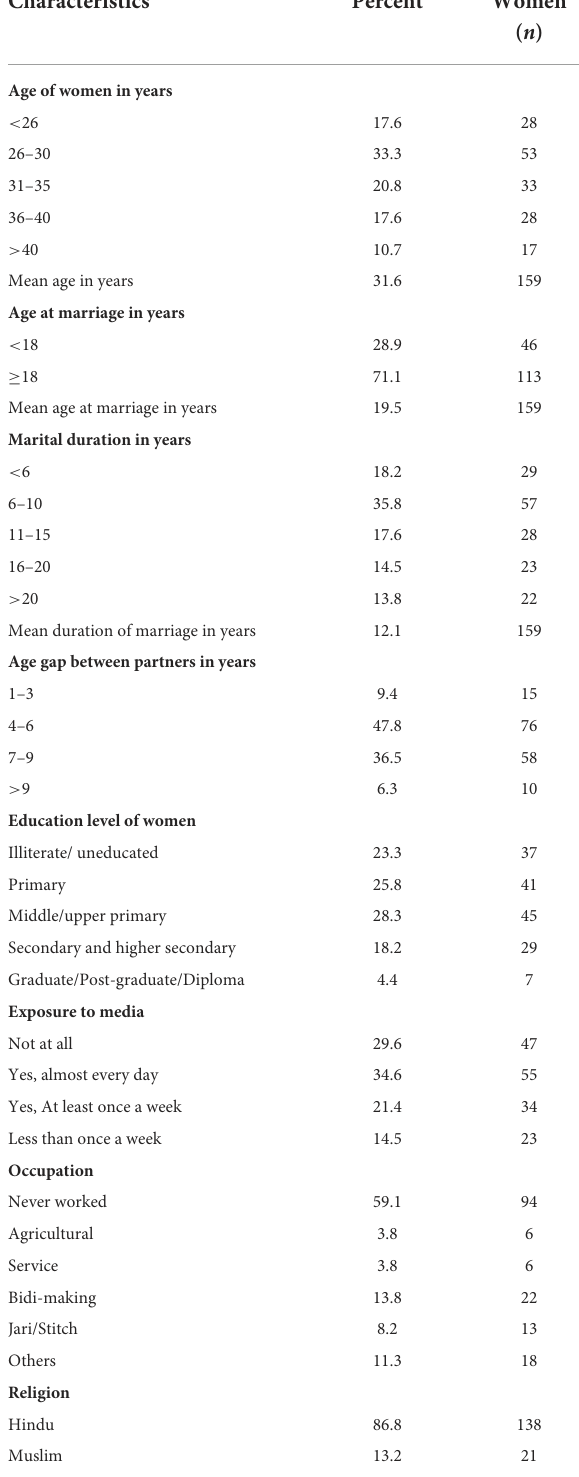
TABLE 1 Percentage distribution of respondents by socio-economic